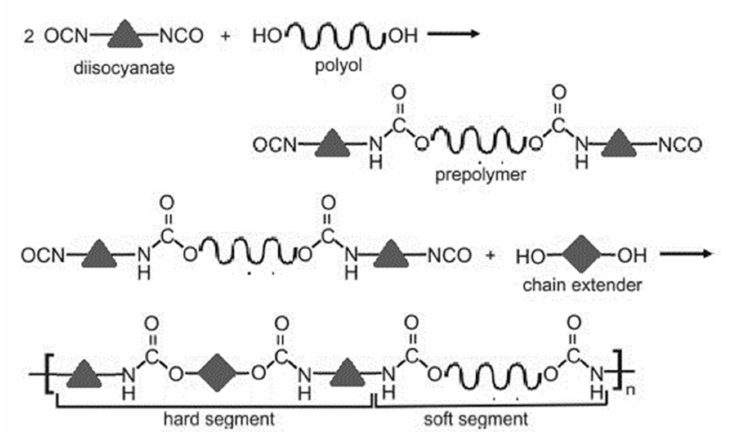
Figure 1. Mechanism of PU